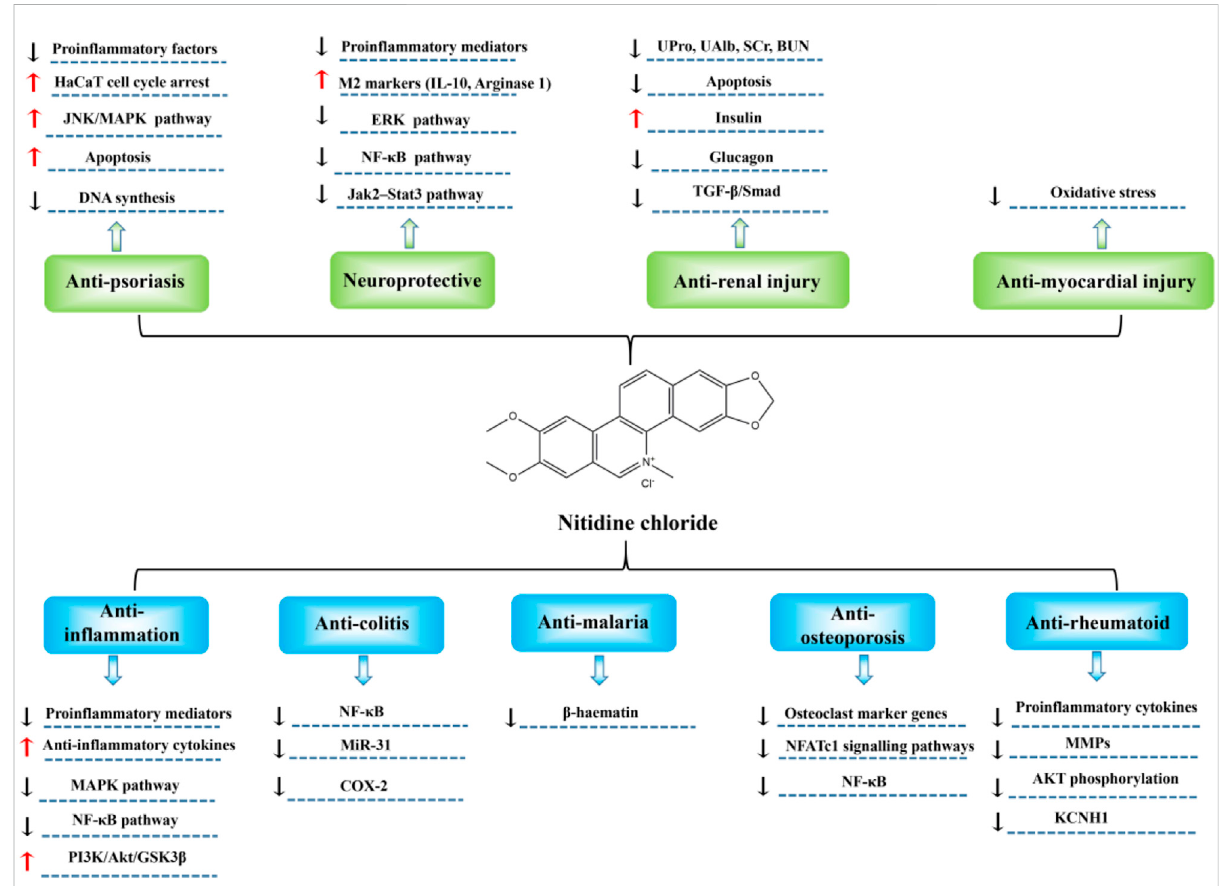
FIGURE 3 Molecular mechanisms of nitidine chloride in the treatment of non-cancer